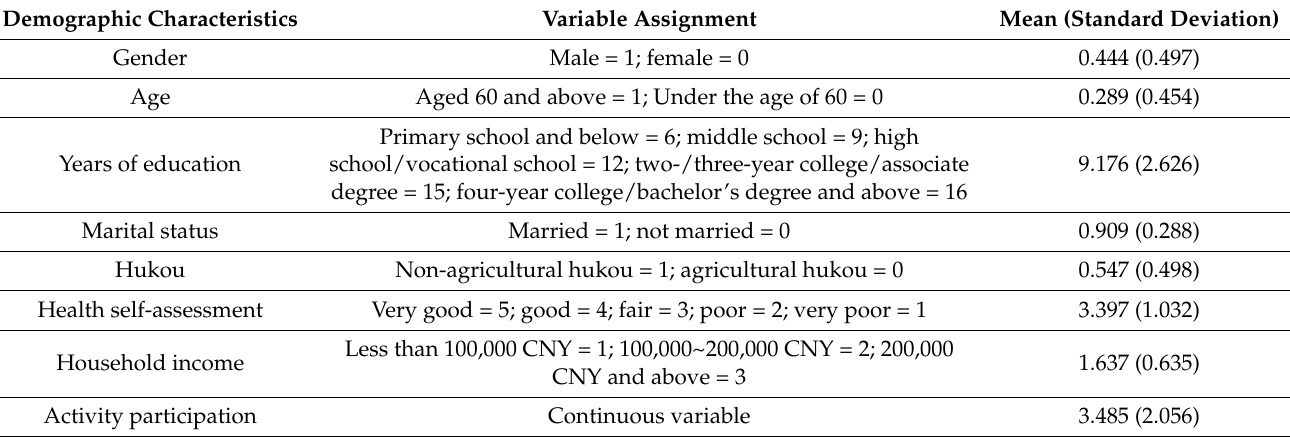
Table 1. Demographic